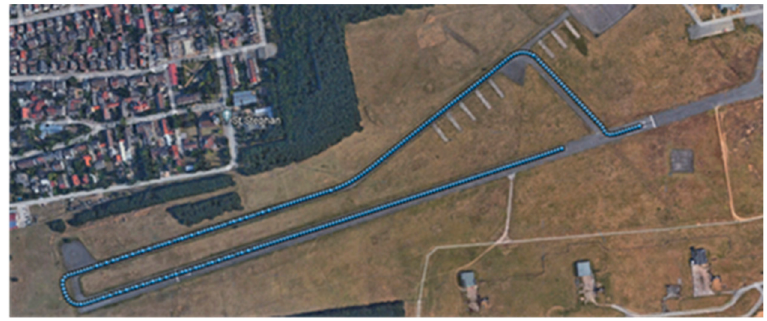
Figure 19. Reference path used for the Frenet transformation.